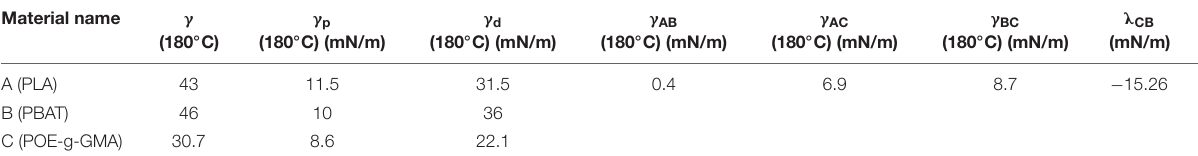
TABLE 4 | Spreading coefficient and interfacial interaction for the PLA / PBAT/ POE-g-GMA system.